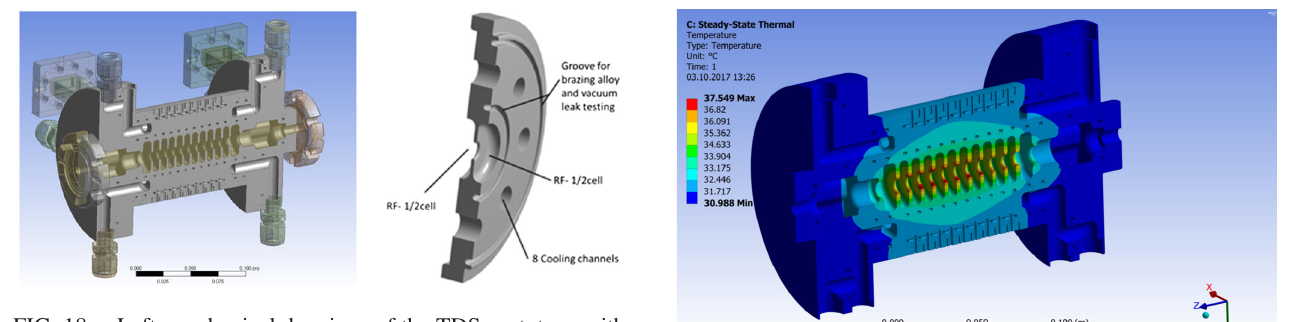
FIG. 18. Left: mechanical drawings of the TDS prototype with few cells. Right: basic disk.